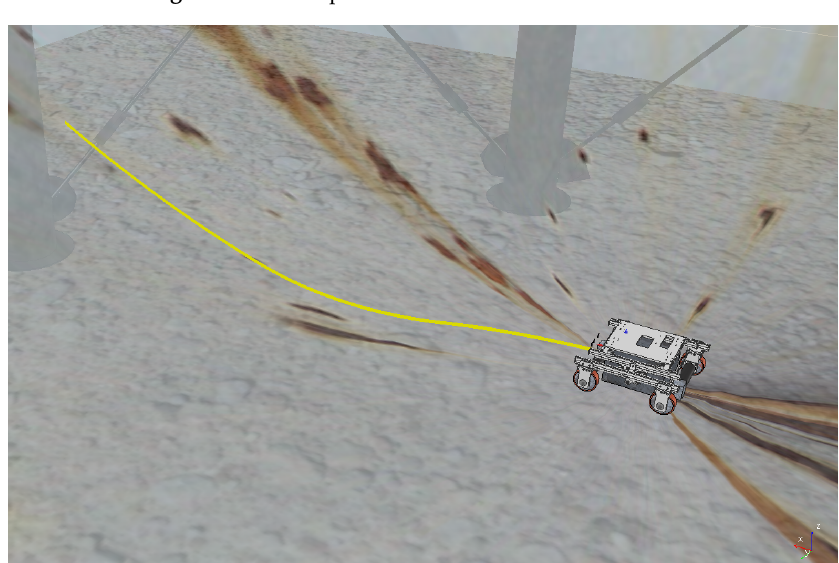
Figure 7. Trajectory of the climbing robot during navigation in the storage